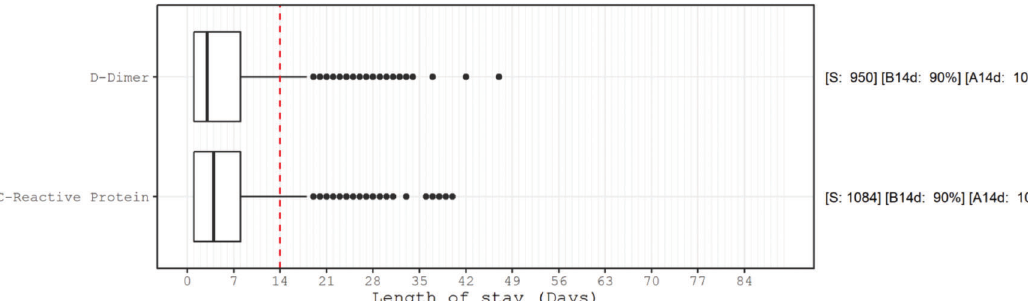
Figure 2 - Box plot of worst test result temporal distribution, sample size, and proportion of the altered results. Distribution of the day of the worst altered (according to the cut-off from Figure 1) results in the D-dimer test and C-reactive protein measurements. Note that 75% of these worst results occurred up to the 8 th day of hospitalization. S: number of patients with altered results; B14d: proportion of altered results before 14 days of hospitalization; A14d: proportion of altered results after 14 days of hospitalization. Table 2 - Crude and adjusted associations of D-dimer and C-reactive protein levels with hospital mortality. D-dimer C-reactive protein Altered (4,000, + ] vs Normal [0, 4,000] Altered (220, + ] vs Normal [0,